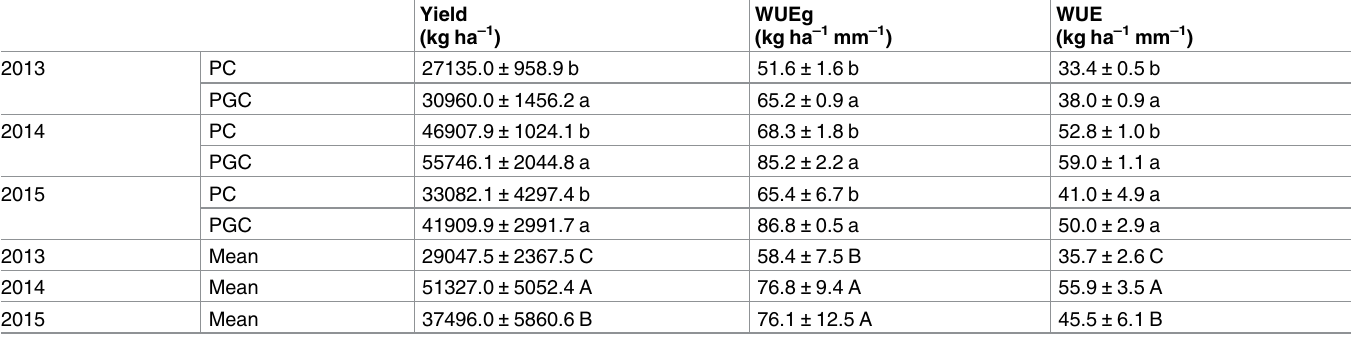
Table 1. Yield, water use efficiency during the cover crop period (WUEg), and total water use efficiency (WUE) under different treatments in the apple orchard.